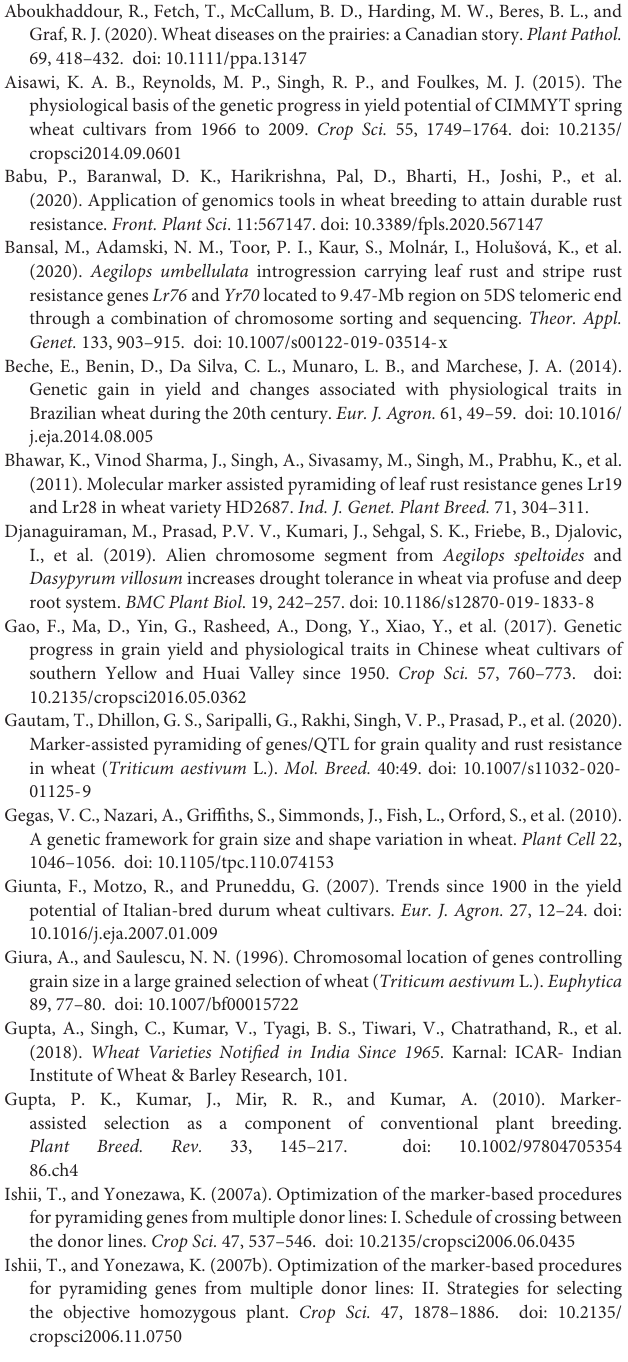
Supplementary Figure 1 | (A) PCR amplification profile of marker Xuhw302 amplifying Yr15 gene in F 3 plants derived from cross HGW550 × PBW550 + Yr15 as on agarose gel. (B) KlusterCaller output view of segregation of Co-dominant Ta5DS-2754099_kasp23 markers in F 3 plants derived from cross HGW550 + Yr15 × PBW550 + Lr57-Yr40 . FAM tailed Lr57-Yr40 (blue color) allele on X -axis, HEX tailed PBW550 alleles (red color) on Y -axis, heterozygous individuals on mid-axis (green color). Black color represents